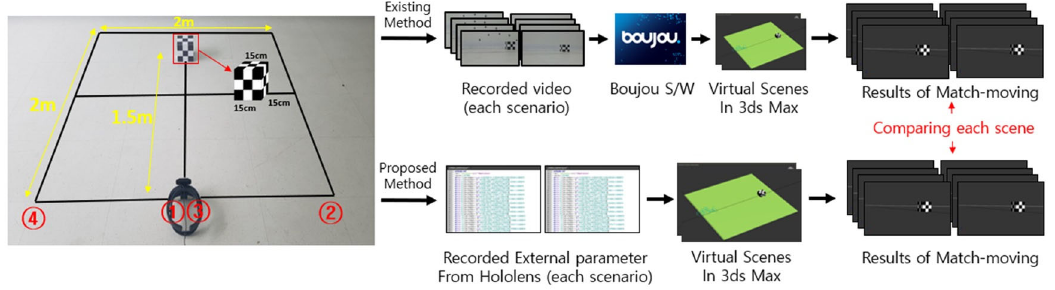
Figure 8. Experimental setup for comparing match-moving results.